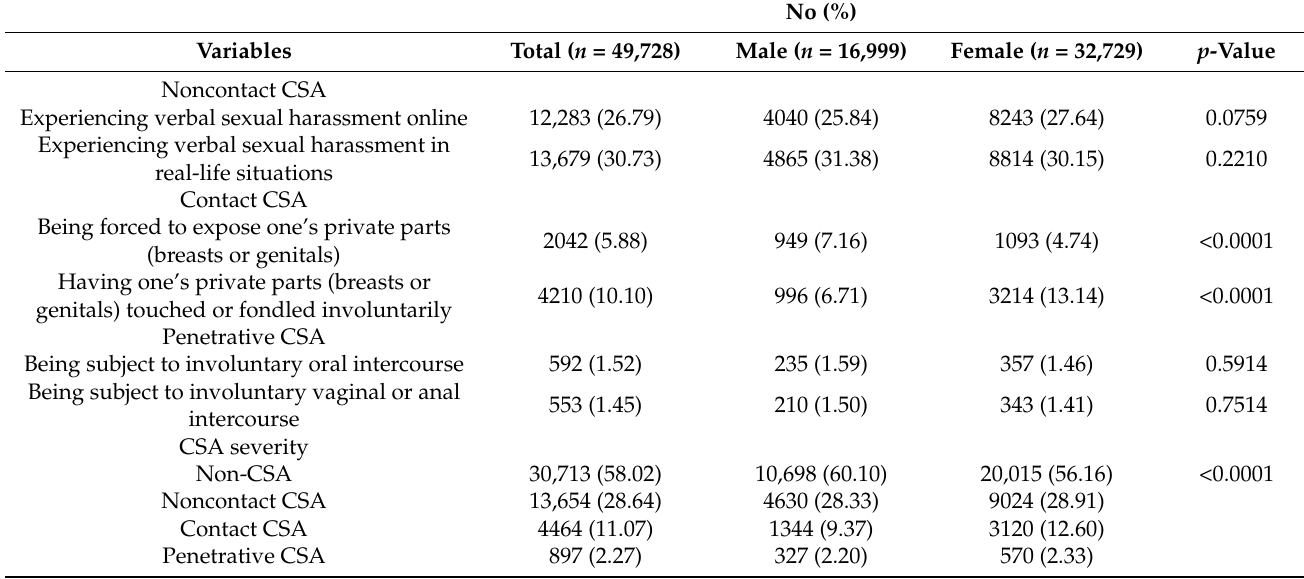
Table 1. Prevalence of childhood sexual abuse among participants by type ( n = 49,728).